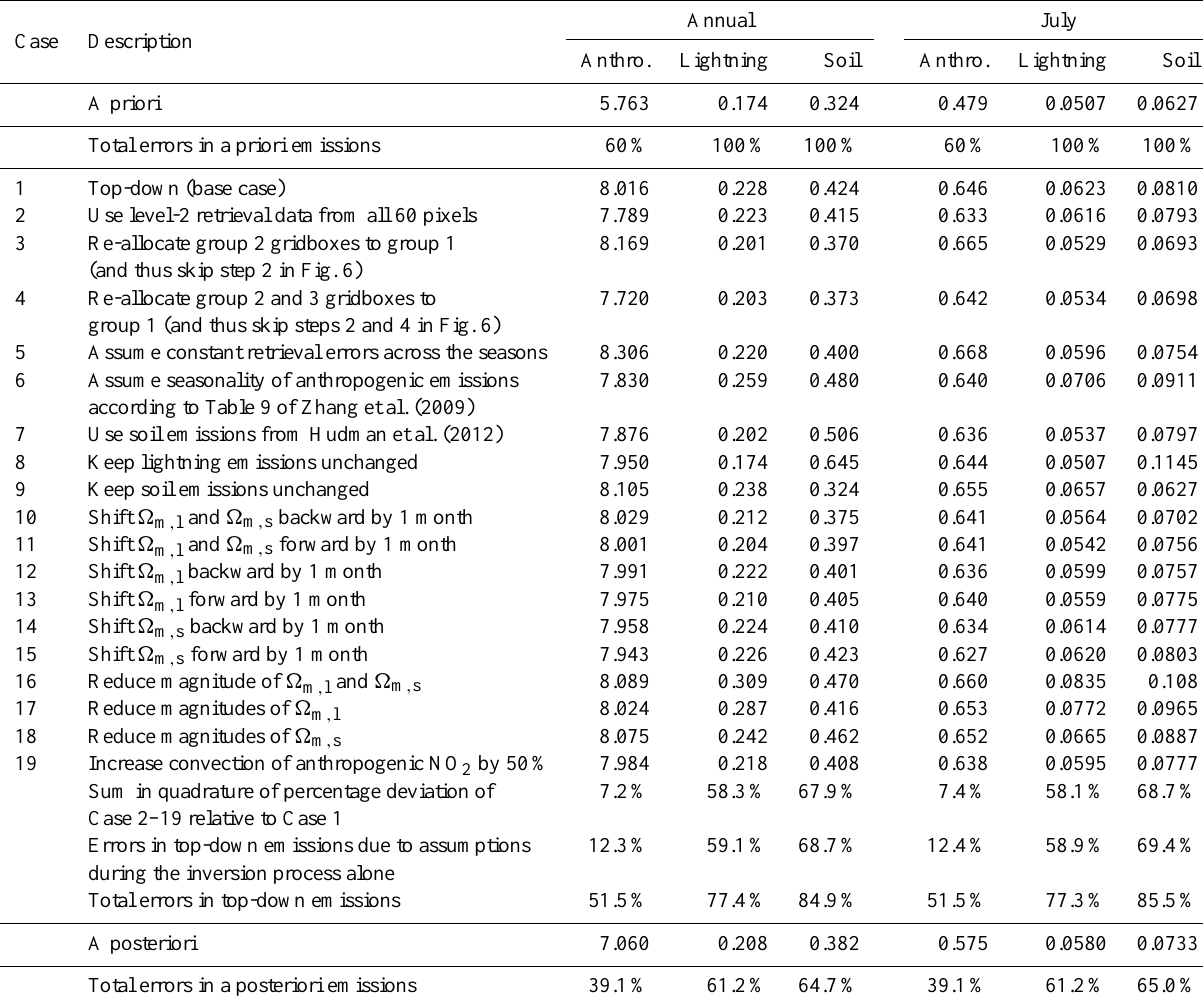
Fig. 2. Seasonal variations of the a priori, top-down and a posteriori anthropogenic, lightning, soil and total emissions of NO x (10 15 molec.cm − 2 h − 1 ) over East China for 2006. Table 1. Emission budgets over East China (TgN) derived from various inversion